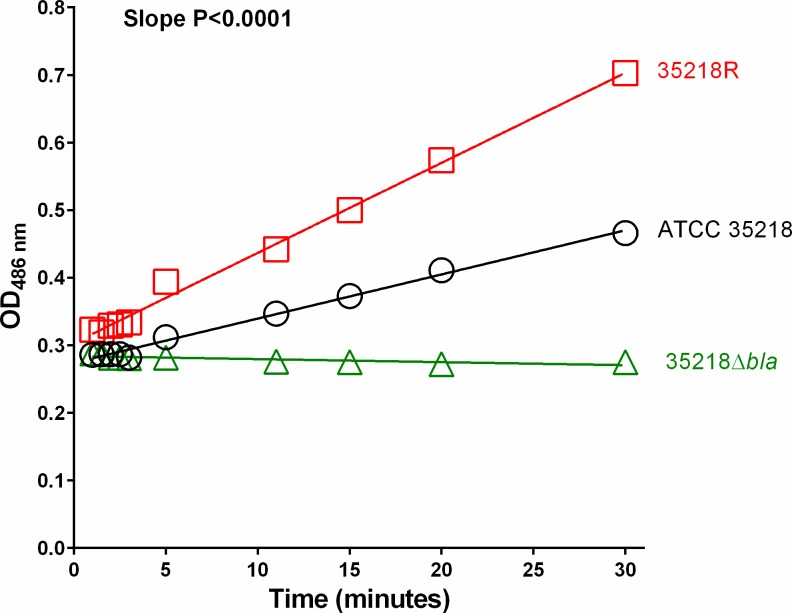
Nitrocefin degradation assay for E. coli ATCC 35218, 35218R and 35218Δbla.Nitrocefin degradation by E. coli 35218R (red squares), E. coli ATCC 35218 (black circles) and E. coli 35218Δbla (green triangles). The absorbance at 480 nm vs. time were modelled by linear regression and compared by curve fitting analysis (CFA). Strain 35218R (red squares and line) hydrolyzed nitrocefin more efficiently than the parental ATCC 35218 (black circles and line), while no hydrolysis occurred with the plasmid-cured isogenic strain 35218Δbla (green diamonds and line), confirming β-lactamase hyperproduction by E. coli 35218R and negligible β-lactamase activity of E. coli 35218Δbla. The P value from the slope comparison indicates that each group is described by an independent line.